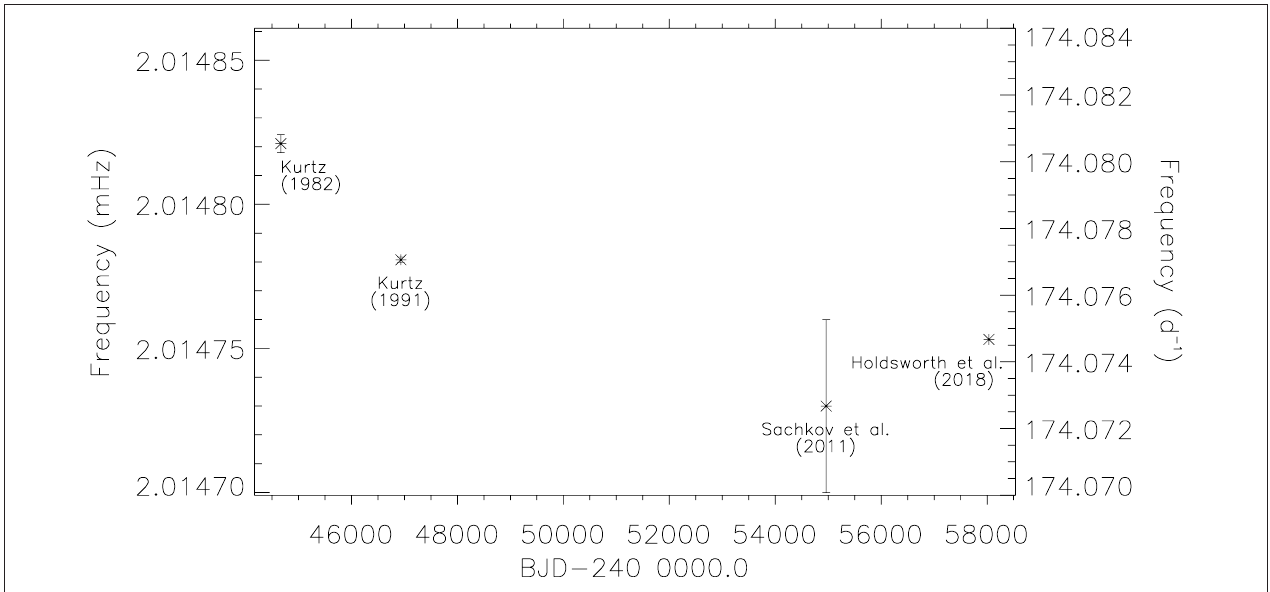
FIGURE 9 | Comparison of the main pulsation frequency reported in 33Lib over 36 year. There is indication that the pulsation frequency, and thus phase, is variable over the observation period. The references for the data are: Kurtz (1982), Kurtz (1991), Sachkov et al. (2011), and Holdsworth et al. (2018).